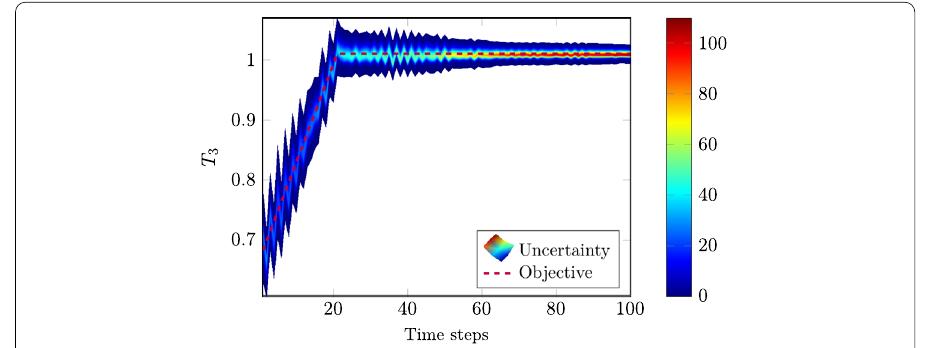
Fig. 25 Evolution in time of T 3 | t when the control is implemented- Case 3